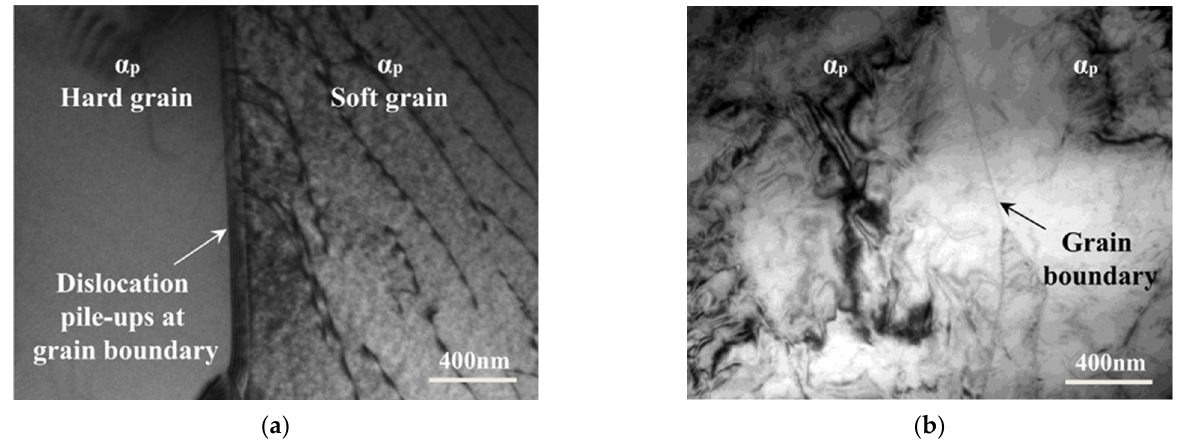
Figure 9. TEM observations of the fatigue specimen cycled to failure at ( a ) low strain amplitude of 0.7% and ( b ) high strain amplitude of 2.0%.